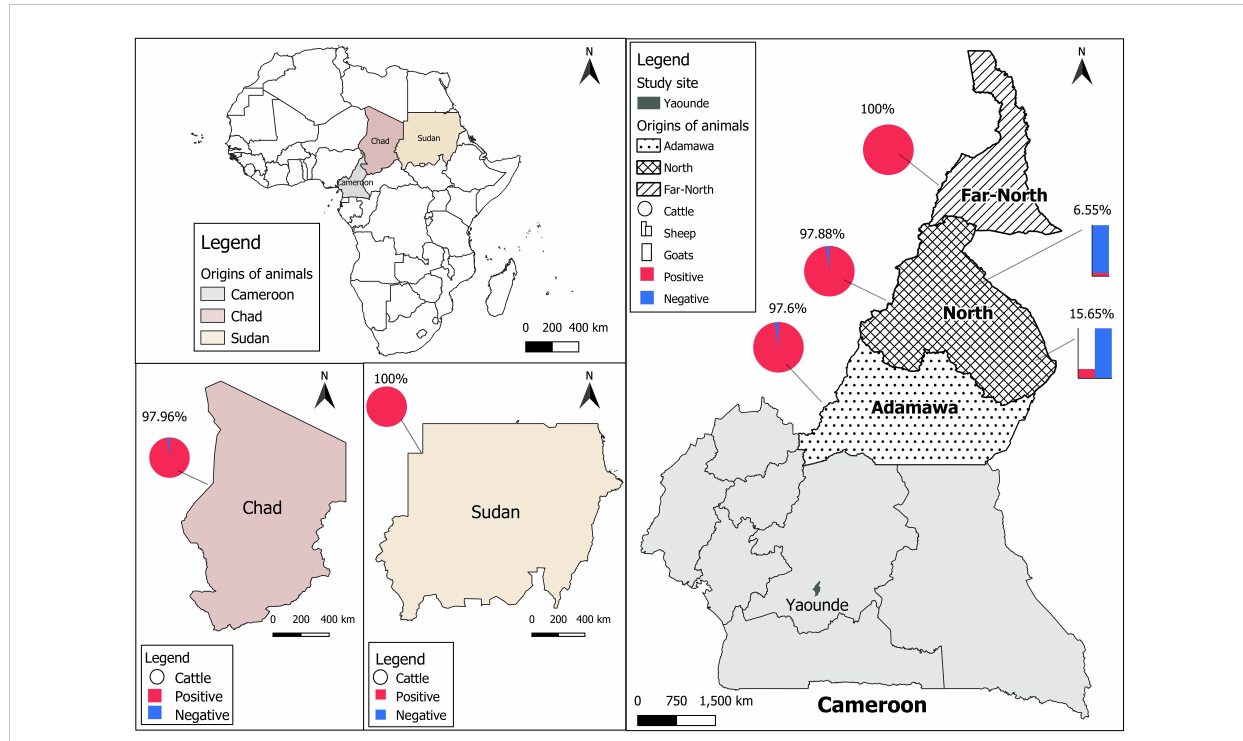
FIGURE 1 Distribution of CCHFV seroprevalence. Cattle data are presented as pie charts, sheep as histogram, and goats by stacked bars. The positive samples are presented in red and the negative ones are in blue. The prevalence of anti-CCHFV antibodies is presented on each country